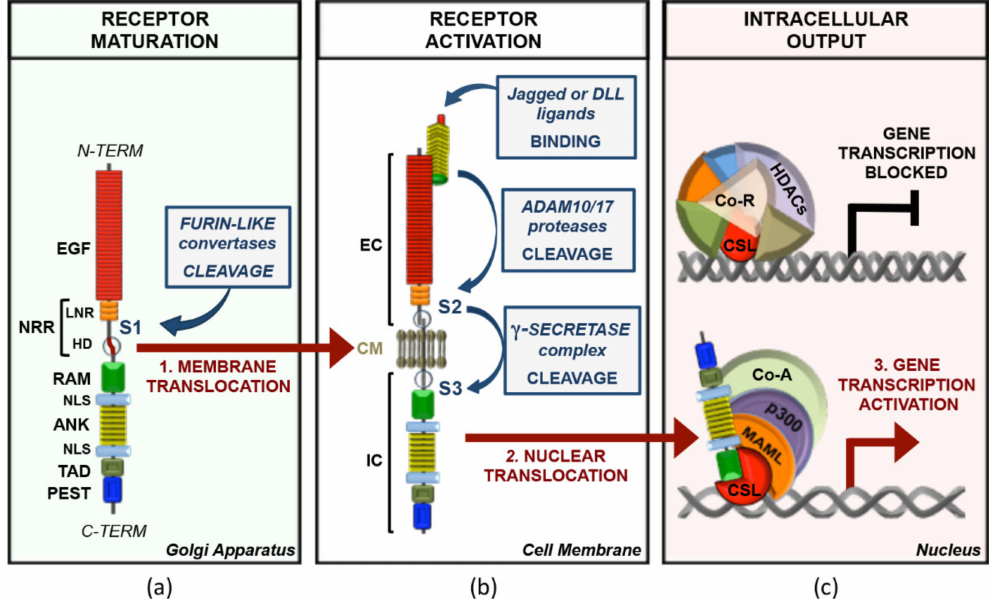
Figure 1. Main framework of canonical Notch signal transduction. ( a ) Notch receptors are synthetized as monomeric precursor proteins, which are subjected to a proteolytic cleavage by furin-like convertases (S1) in the Golgi apparatus before being exposed to the cell membrane as non-covalently linked heterodimers. From the N- to the C-terminal, the mammalian Notch proteins comprises: EGF (epidermal growth factor-like repeats), NRR (negative regulatory region), LNR (Lin12/Notch repeats), HD (heterodimerization domain), RAM (RBP-jk associated molecule), NLS (nuclear localization signal), ANK (ankyrin repeats), TAD (transactivation domain), and PEST (proline, glutamic acid, serine, and threonine). ( b ) The interaction of a Jagged or DLL (Delta-like ligand) family ligand to the EC (extracellular fragment) of the trans- membrane Notch receptor leads to the S2 cleavage of the receptor by ADAM10/17 (a disintegrin and metalloproteinase) and the subsequent S3 proteolysis catalyzed by the γ -secretase complex. This last cleavage releases from the membrane the IC (intracellular fragment) of Notch, which translocates to the nucleus. ( c ) In the absence of Notch, the transcription factor CSL (CBF-1/SuH/Lag-1 DNA-binding protein), in association with several Co-R (co-repressors factors) and HDACs (histone deacetylases) on the regulatory regions of Notch target genes, acts as a transcriptional repressor. The binding of the Notch IC to CSL displaces from CSL the Co-R, and by recruiting MAML (Mastermind-like), p300, and distinct context-related Co-A (co-activators factors), target genes’ transcription is switched to an activated state. In absence of ligands, NRR restrains Notch signaling by hindering the ADAM10/17 (a disintegrin and metalloproteinase)-dependent proteolytic S2 sites that lie at the extracel- lular region of the NTM. Ligand binding causes the stretching of the NRR structure that unmasks S2 site and allows the ADAM10 metalloprotease-dependent proteolysis of the receptor. This process generates an intermediate transmembrane fragment termed Notch extracellular truncation (NEXT), which is rapidly cleaved by the intramembrane